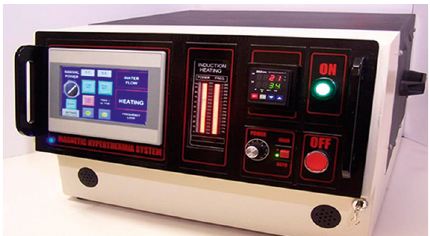
Figure 1: Magnetic hyperthermia apparatus